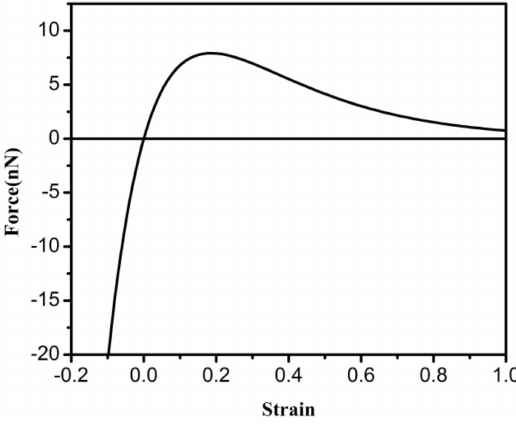
Figure 1. The force–strain curve of C–C